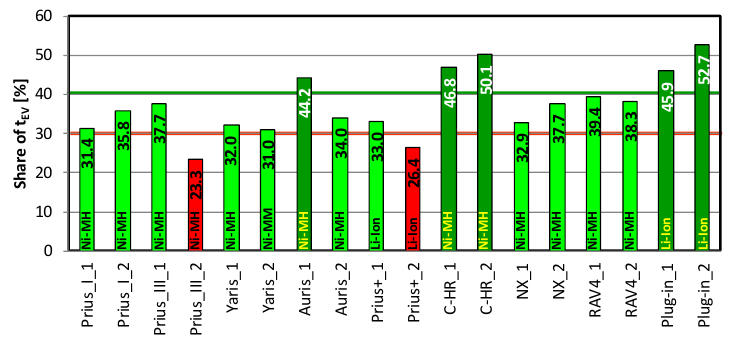
Figure 13. Shares of electric driving in urban conditions for individual vehicles.